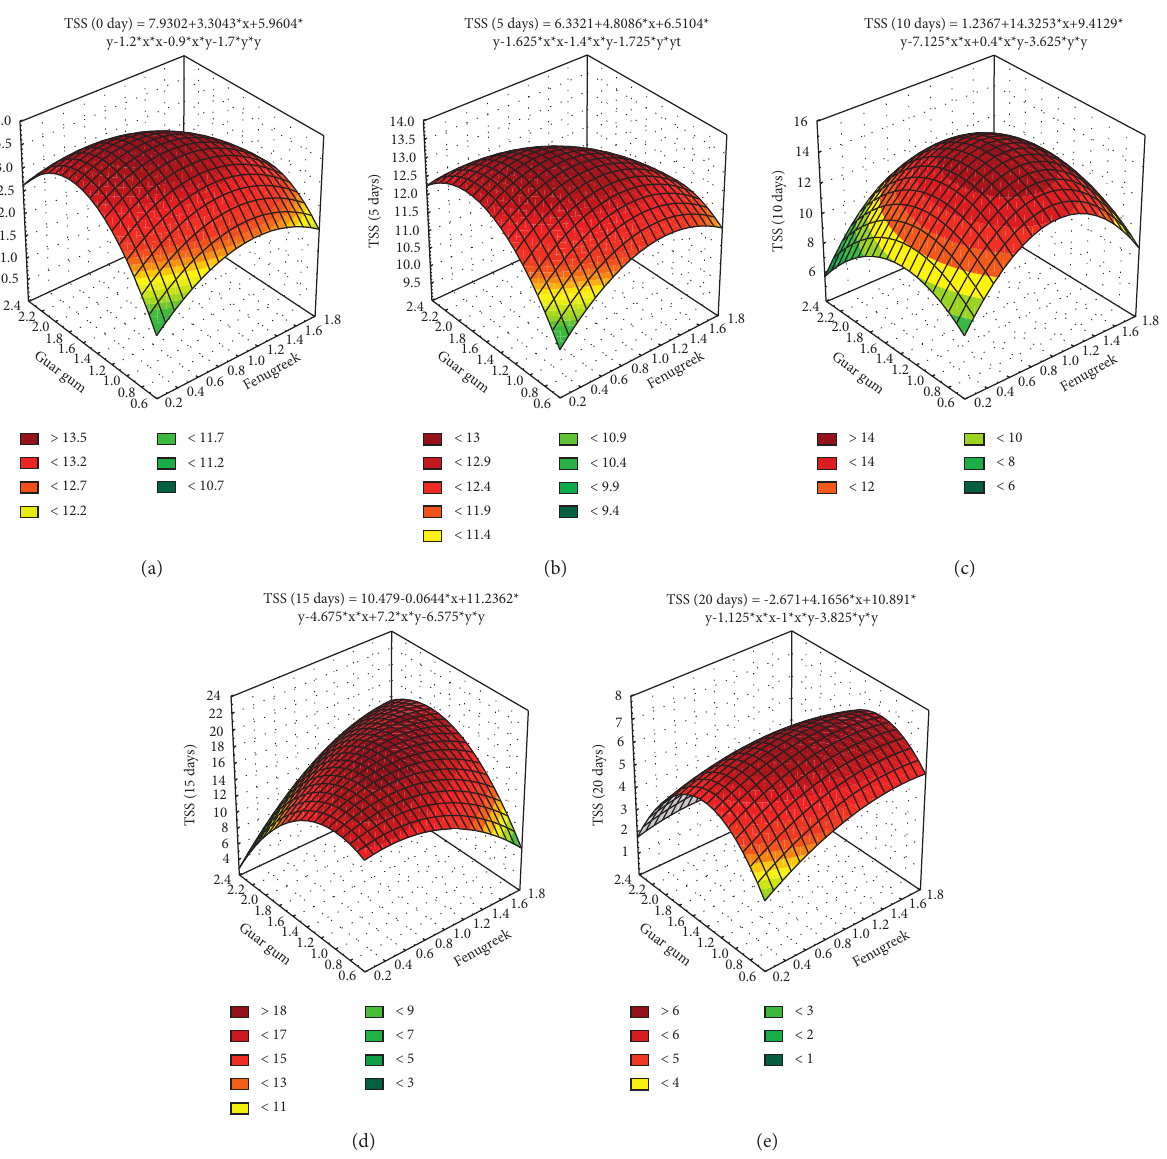
Figure 4: Response surface plot showing the impact of guar galactomannan and fenugreek galactomannan on TSS of guava fruit during storage. (a) TSS (0 days) � 7.9302+3.3043 ∗ x +5.9604 ∗ y − 1.2 ∗ x ∗ x − 0.9 ∗ x ∗ y − 1.7 ∗ y ∗ y. (b) TSS (5 days) � 6.3321+4.8086 ∗ x